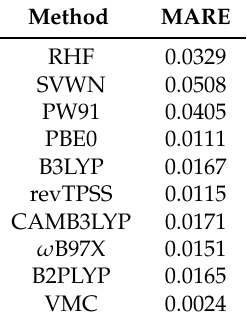
Table 4. Mean absolute relative error (MARE) on Shannon entropy computed at different levels with respect to